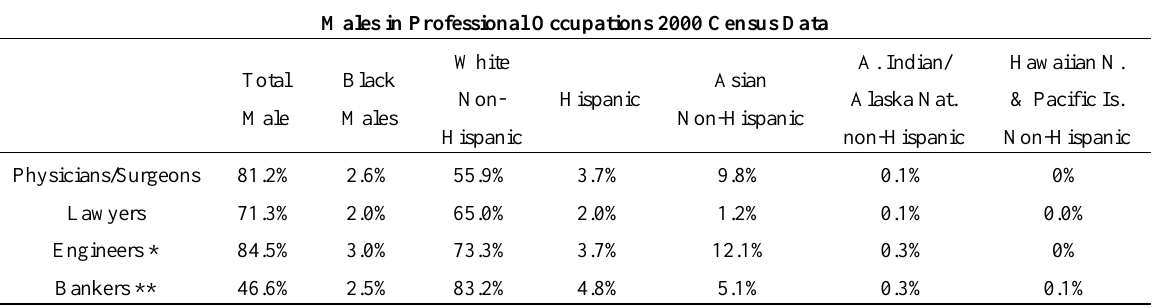
Table 1. Percentages of males employed as doctors, lawyers, engineers, and